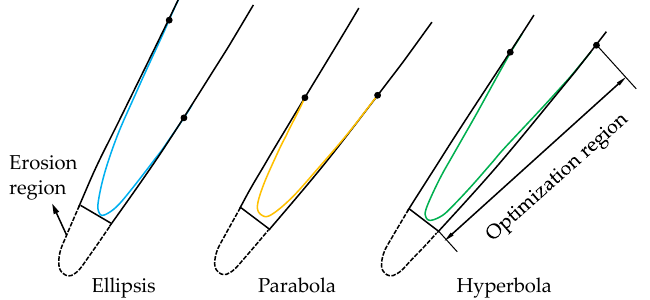
Figure 22. Possible optimized leading-edge contours for the eroded leading edge. Reproduced from [33].